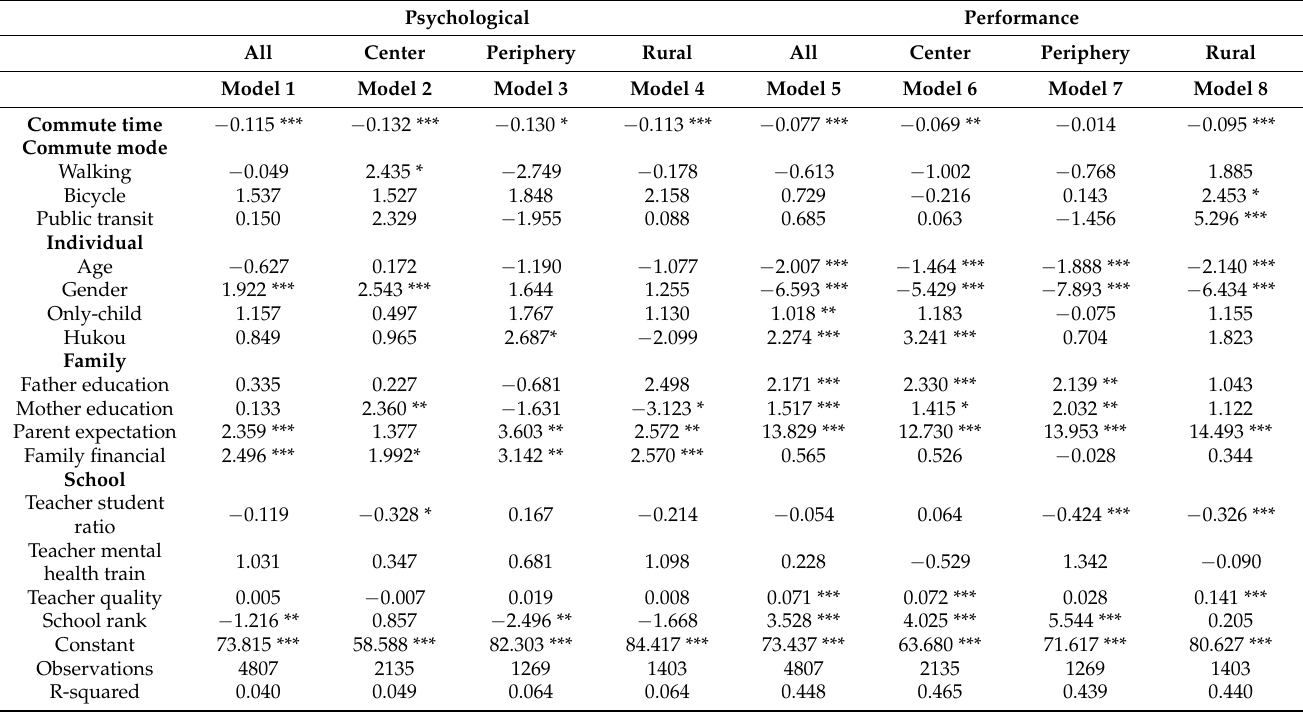
Table 3. Estimation results of the influences of explanatory variables on child